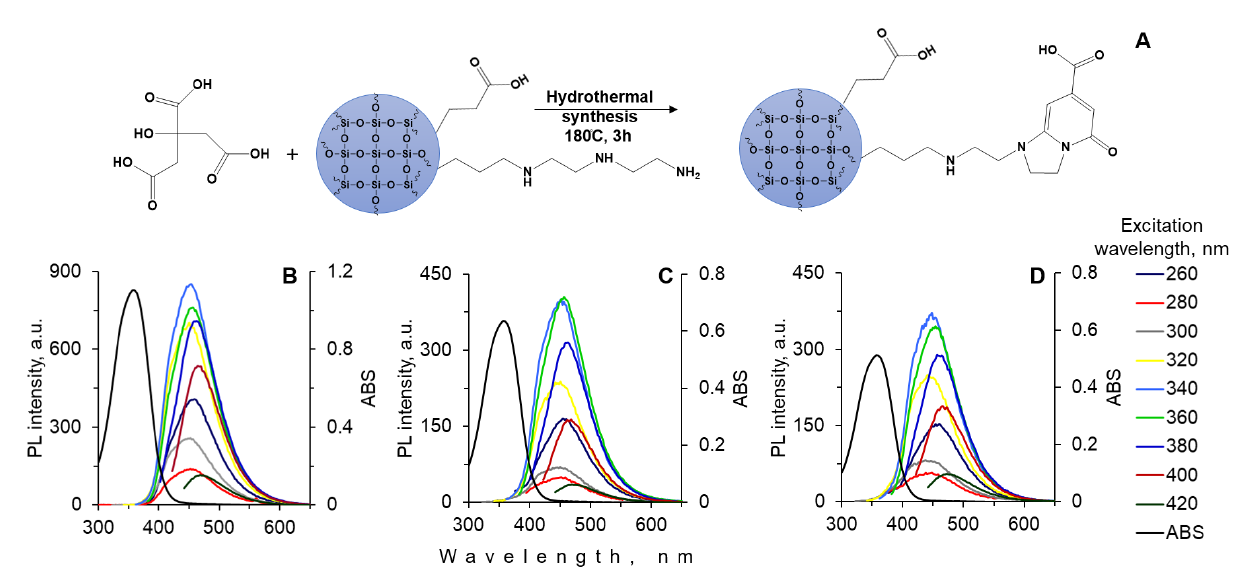
Figure 3. Schematic illustration of the IPCA-type fluorophore formation on the surface of a silica matrix ( A ); the absorption and luminescence spectra of composite nanoparticles with different ratios of the silica surface modifiers of DETAS and CEST: 50:50 ( B ), 40:60 ( C ), and 20:80 ( D ) at different excitation wavelengths.